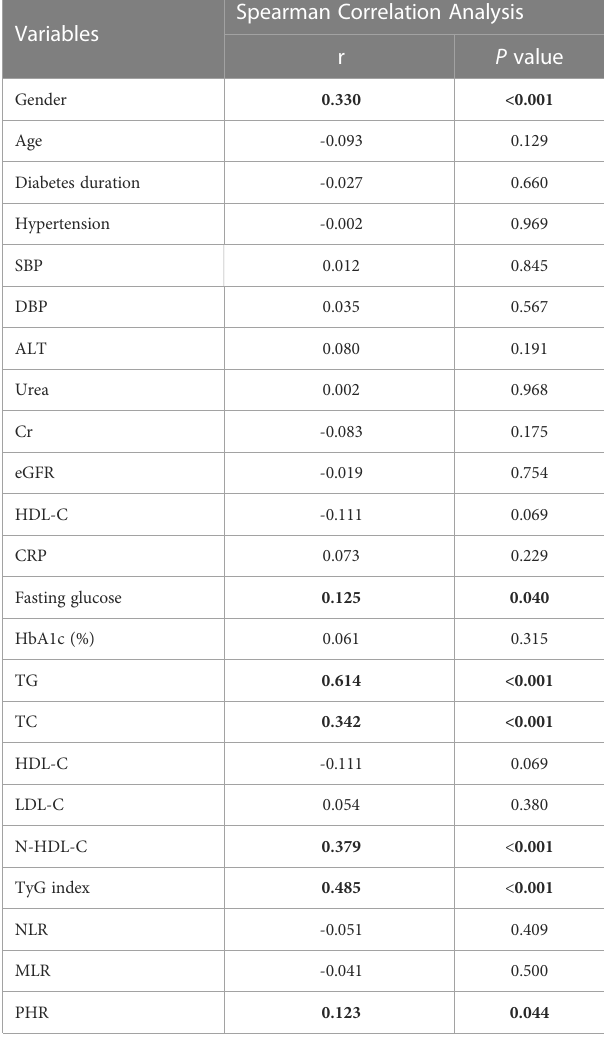
TABLE 5 Correlation of RC with other potential risk factors in the T2DM-PAD patients.